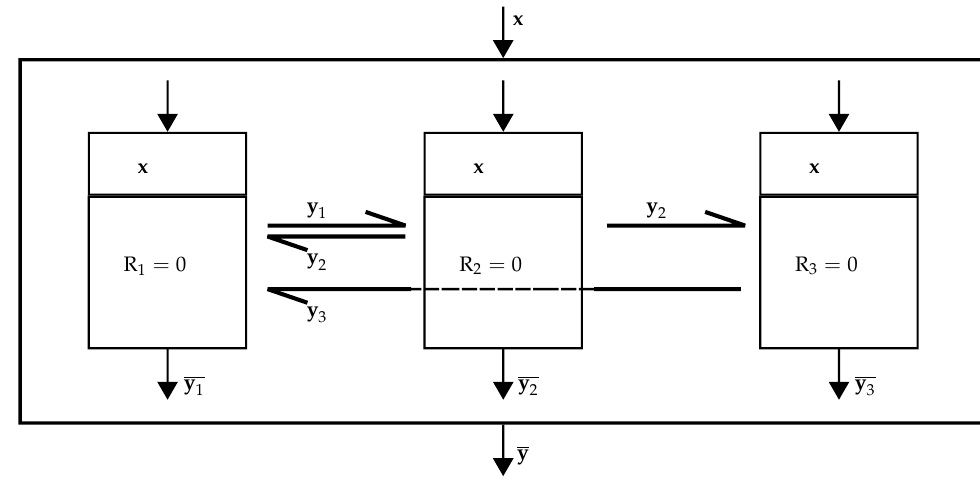
Figure 4. An MDA with 3 interacting CAs.